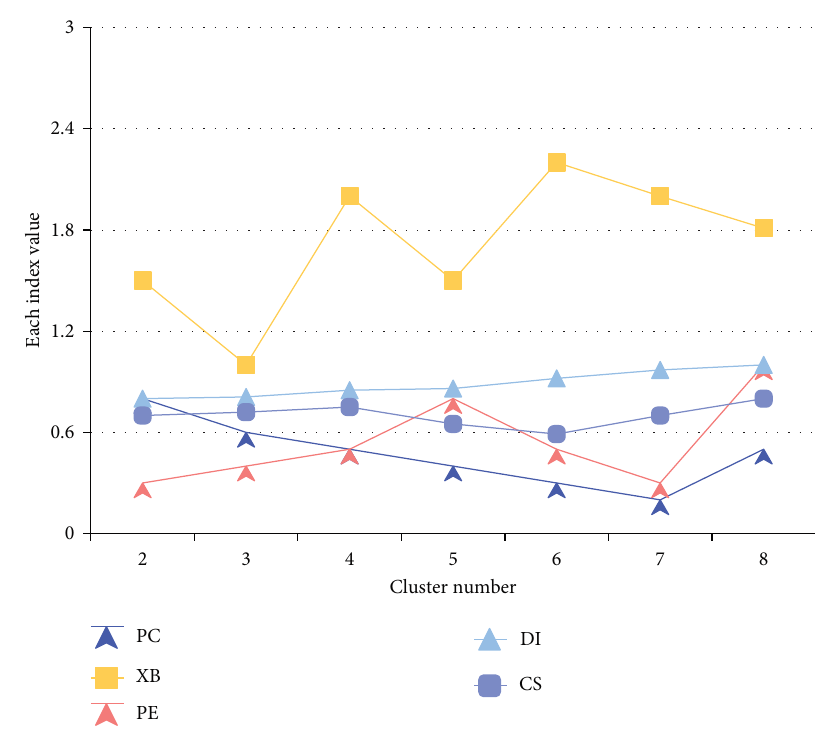
Figure 9: Experimental results on dataset Table 1: Effect evaluation of student mental health assessment system based on Internet of Things and big data technology.